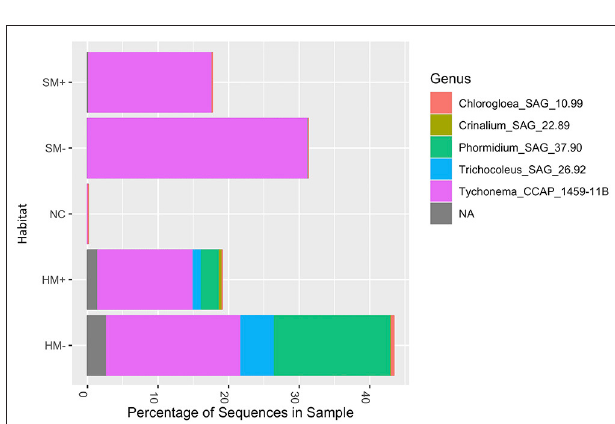
FIGURE 5 | Community profile plots showing the relative abundance of Cyanobacteria genera found the four sampled biocrust habitats and bare soil. OTUs with < 0.01% abundance across all samples were removed prior to analysis; remaining abundance data were normalized through cumulative-sum scaling and log 2 transformed. HM, hypolithic moss biocrust; HM-, hypolithic microbial biocrust; SM, surface moss biocrust; SM-, surface microbial biocrust; NC, non-crusted bare